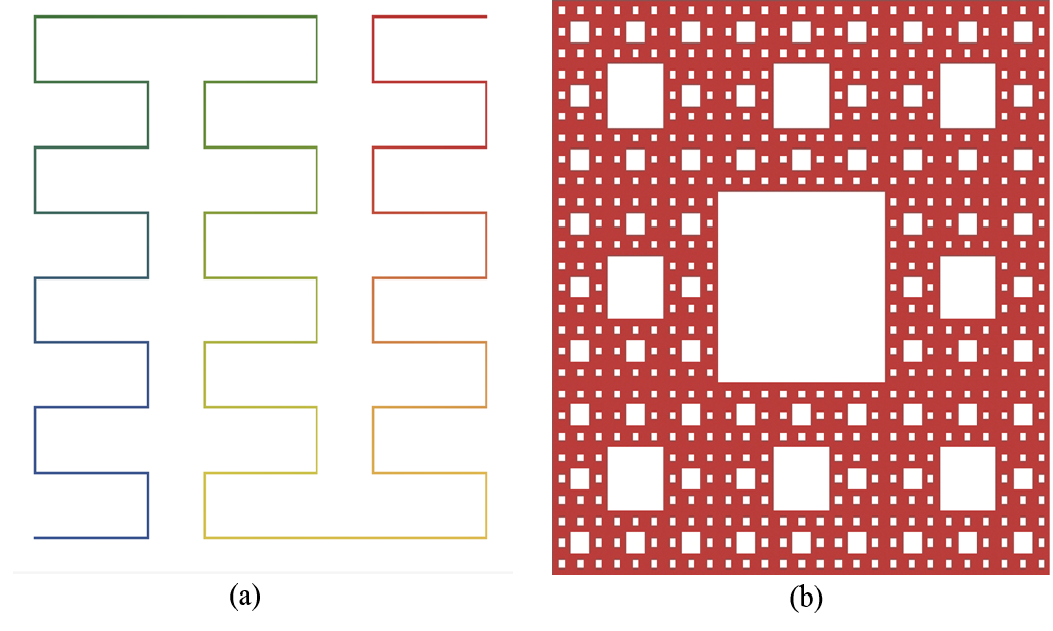
Figure 3. Peano curve ( a ) and Sierpinski carpet ( b